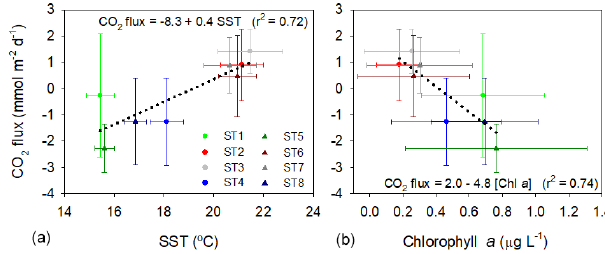
Figure 11. Correlations between the mean values of air–sea CO 2 fluxes and sea surface temperature (SST) for the underway database (a) and the CO 2 fluxes and chlorophyll a (Chl- a ) at the 16 discrete surface stations (b) for each cruise and showing the stan- dard